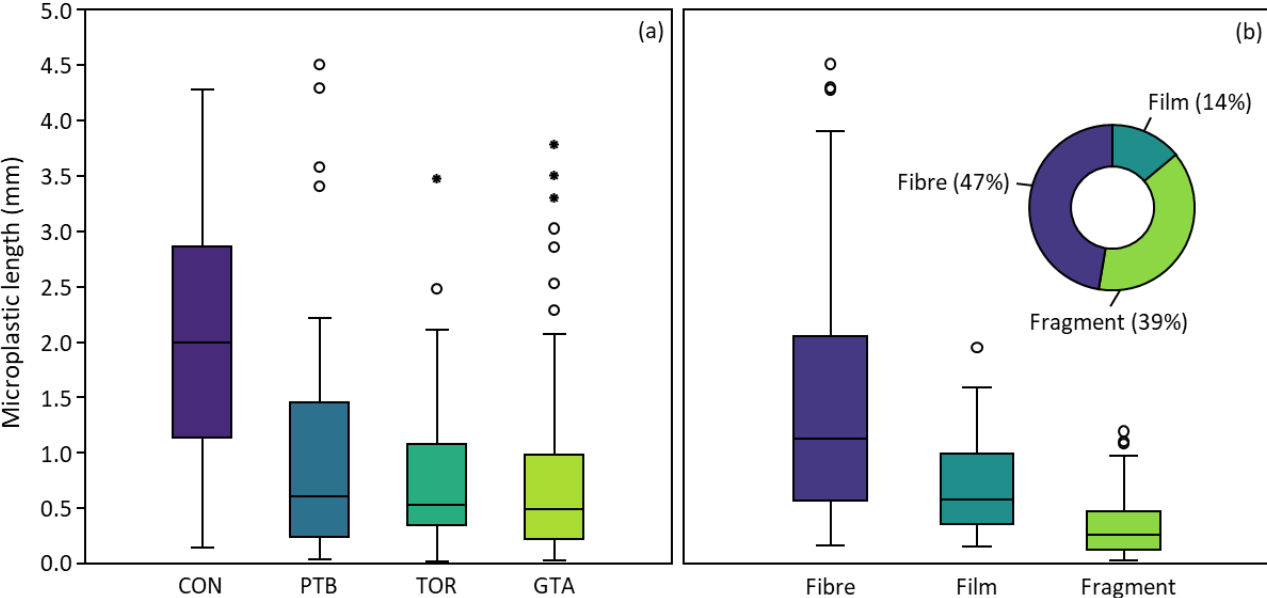
Figure 3. Boxplots showing the distribution of microplastic length in moss bags ( a ) deployed across the three urban intensity groups (PTB, TOR, and GTA) and in the unexposed (control) moss bags (CON), and ( b ) by particle type (fibre, fragment, or film) across all exposed and unexposed moss bags during the deployment period (45 days; 9 October – 23 November 2020). The inset ( b ) doughnut chart shows the percentage of total microplastics composed of fibres (47%), fragments (39%), and films (14%). Note: four microfibres >5 mm were removed from the dataset.